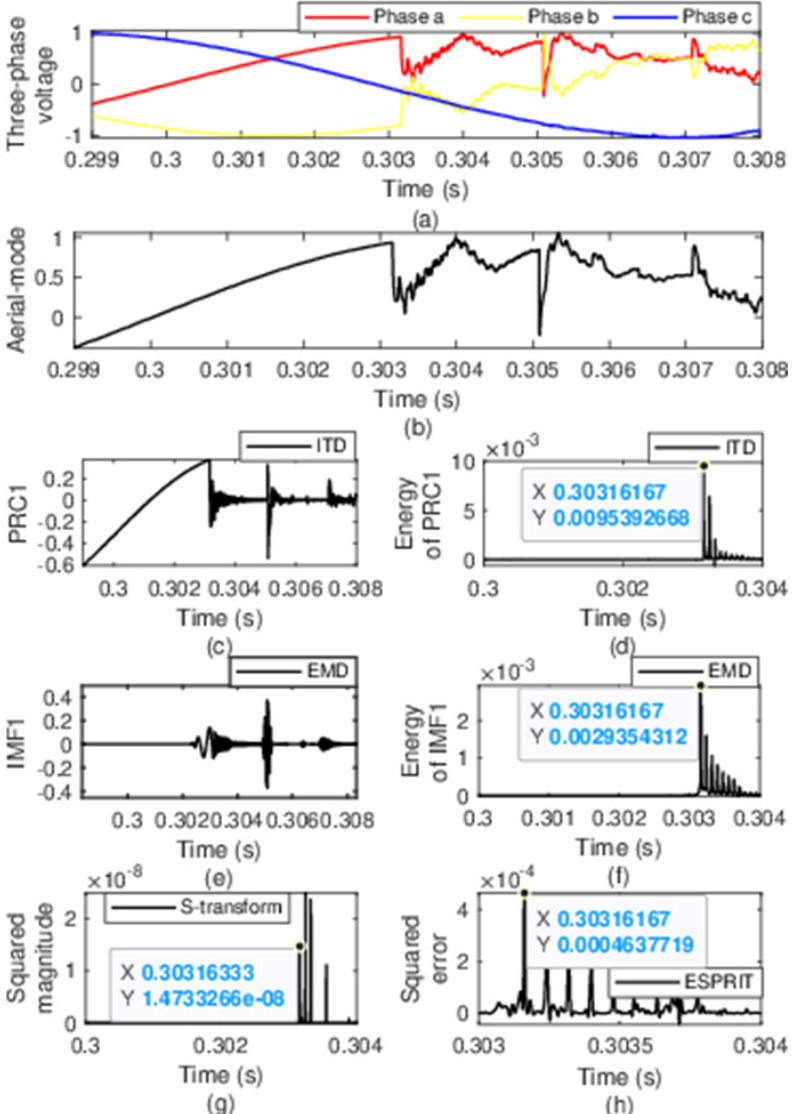
Figure 2. Estimation of ATWs. ( a ) Three-phase voltage signal. ( b ) Aerial-mode signal. ( c ) PRC1 obtained from ITD. ( d ) Energy of PRC1. ( e ) IMF1 obtained from EMD. ( f ) Energy of IMF1. ( g ) Squared-magnitude obtained from ST. ( h ) Squared-error obtained from ESPRIT.